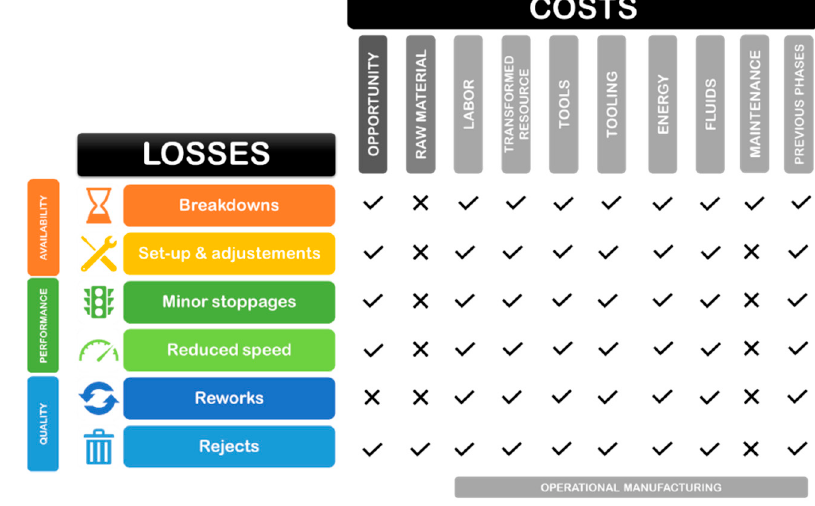
Figure 2. Costs for each loss